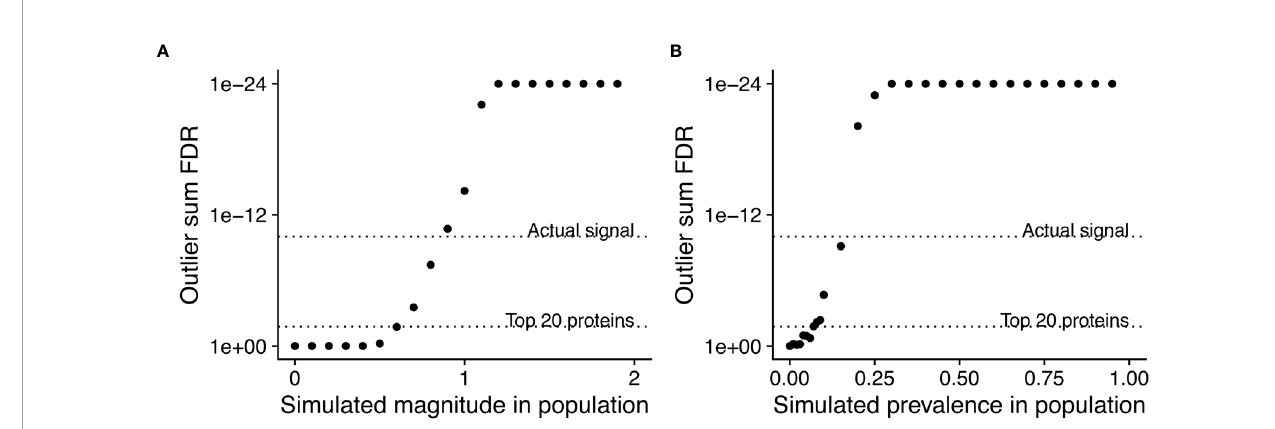
FIGURE 3 | Simulations of magnitude and prevalence of autoantigenic signal to assess statistical limits of detection for PIWAS. SERA datasets from a cohort of SLE patients and kmer enrichments on small nuclear ribonucleoprotein-associated proteins B and B ’ were used as the actual biological signal (magnitude = 1 and prevalence = 19%). The magnitude (A) and prevalence (B) of the kmer signal in this cohort was synthetically modulated to understand the statistical limits of detection for